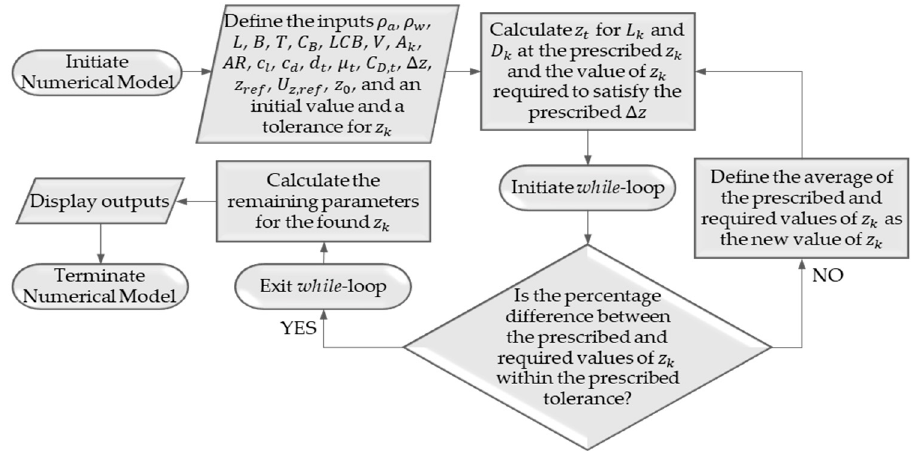
Figure 3. A flow chart explaining the main steps of the algorithm adopted for the numerical model.